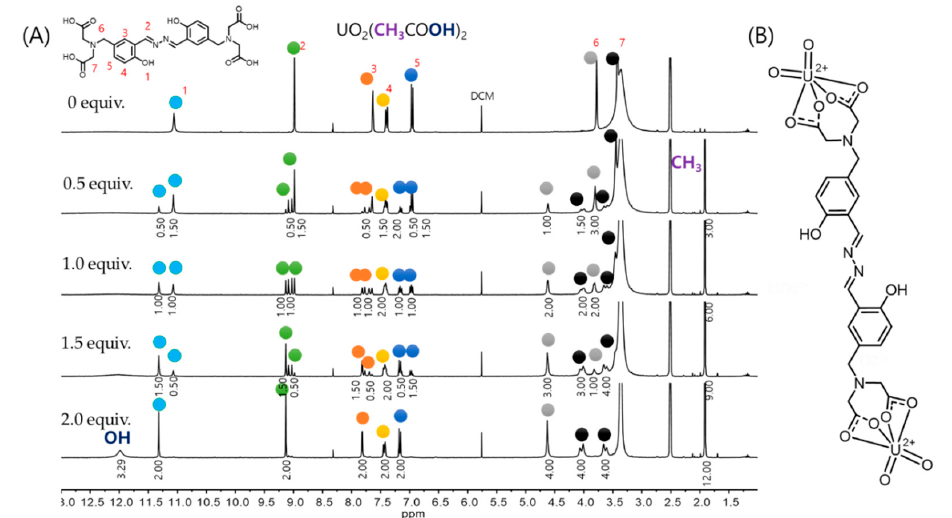
Figure 3. ( A ) 1 H nuclear magnetic resonance (NMR) spectra of compound 1 (10 mM) in DMSO- d 6 containing various equivalents of uranyl acetate. ( B ) Proposed structure of complex 1 with UO 22+ .